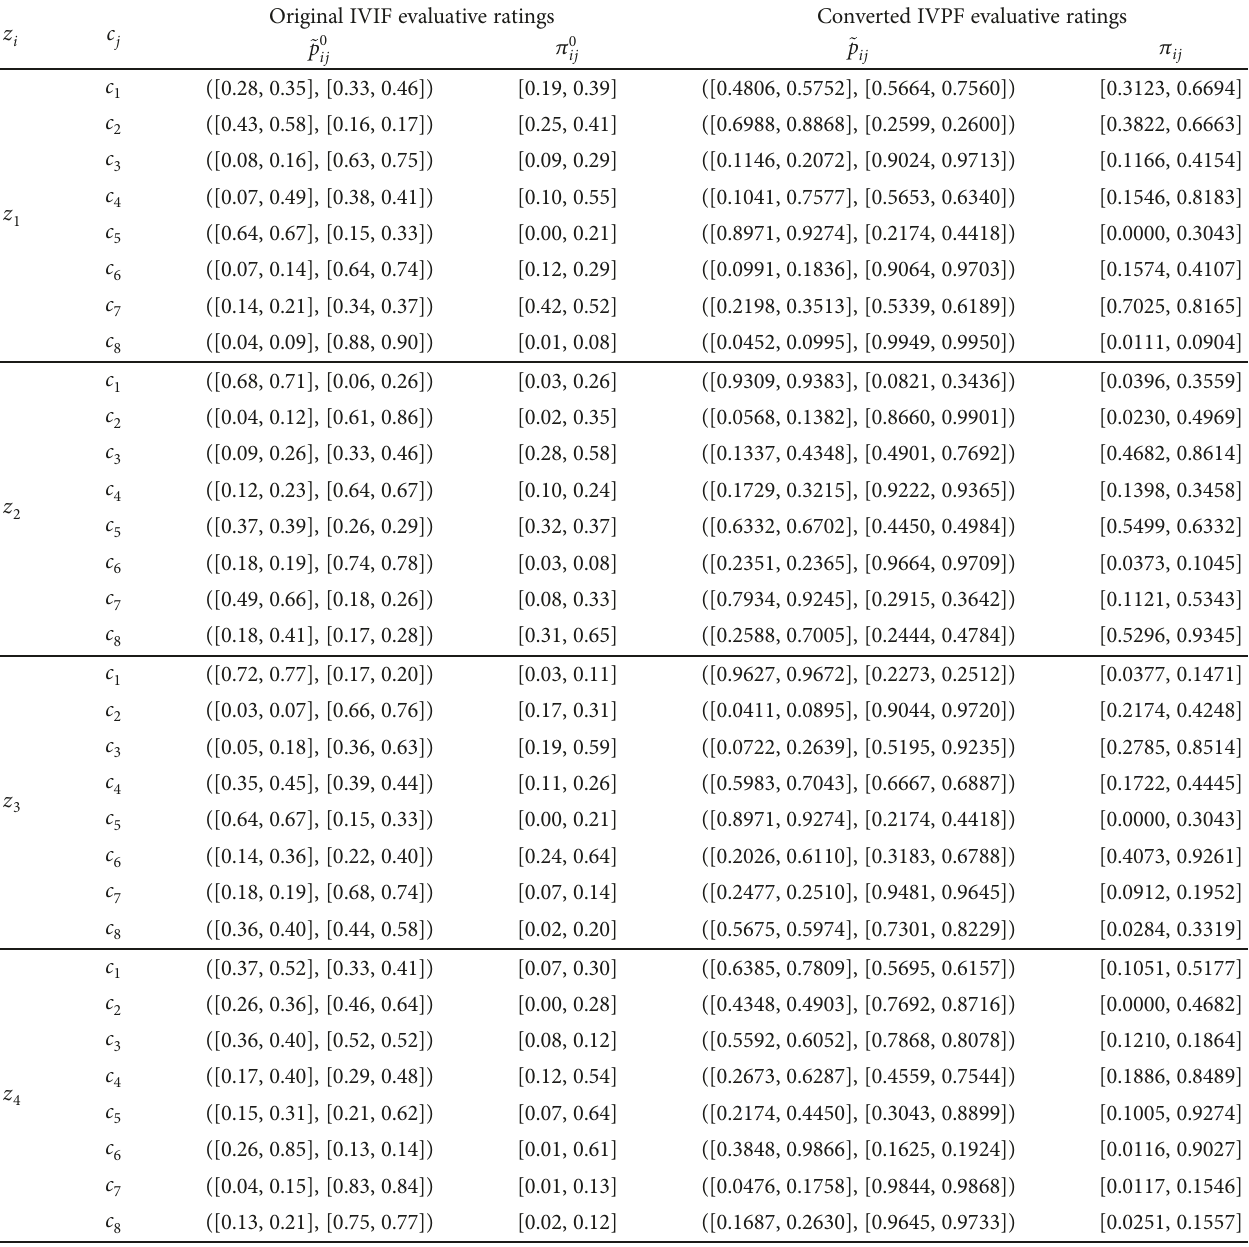
Table 1: Evaluative ratings and indeterminacy intervals in the bridge construction